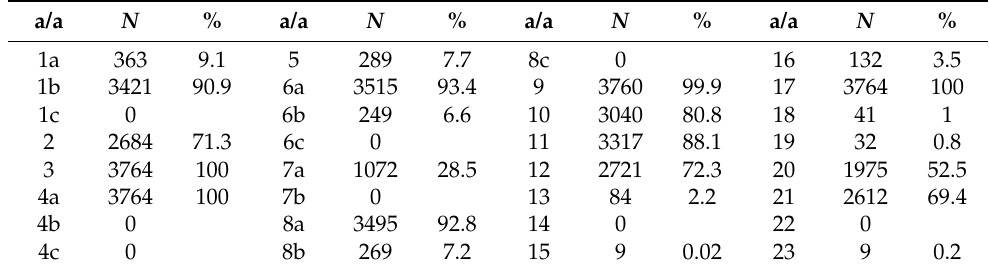
Table 4. Descriptive results of activities score items measured by the NAS